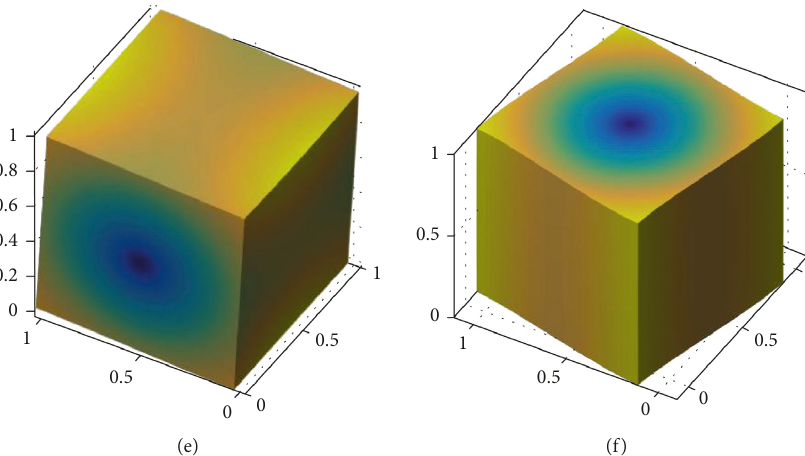
Figure 9: Mode shapes of orthotropic rectangular plates with the E4E4E4E4 boundary condition: (a) 1st mode; (b) 2nd mode; (c) 3rd mode; (d) 4th mode; (e) 5th mode; (f) 6th